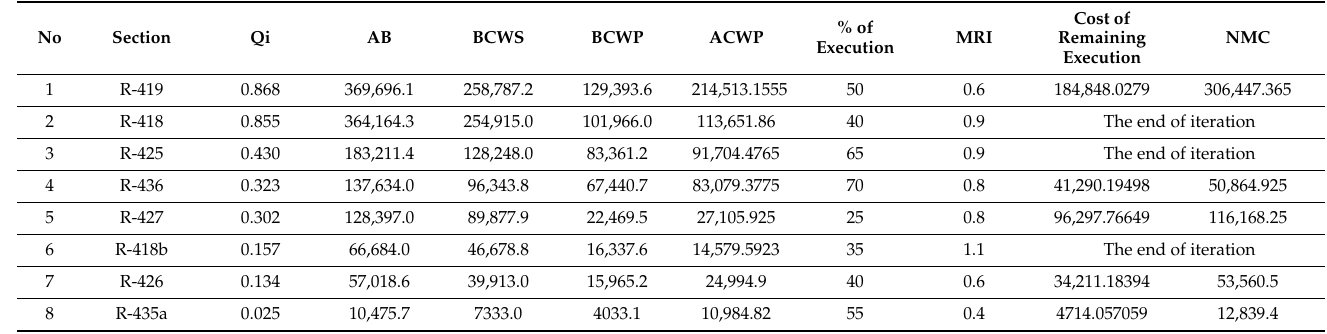
Table 10. Results of monitoring and control process—Iteration